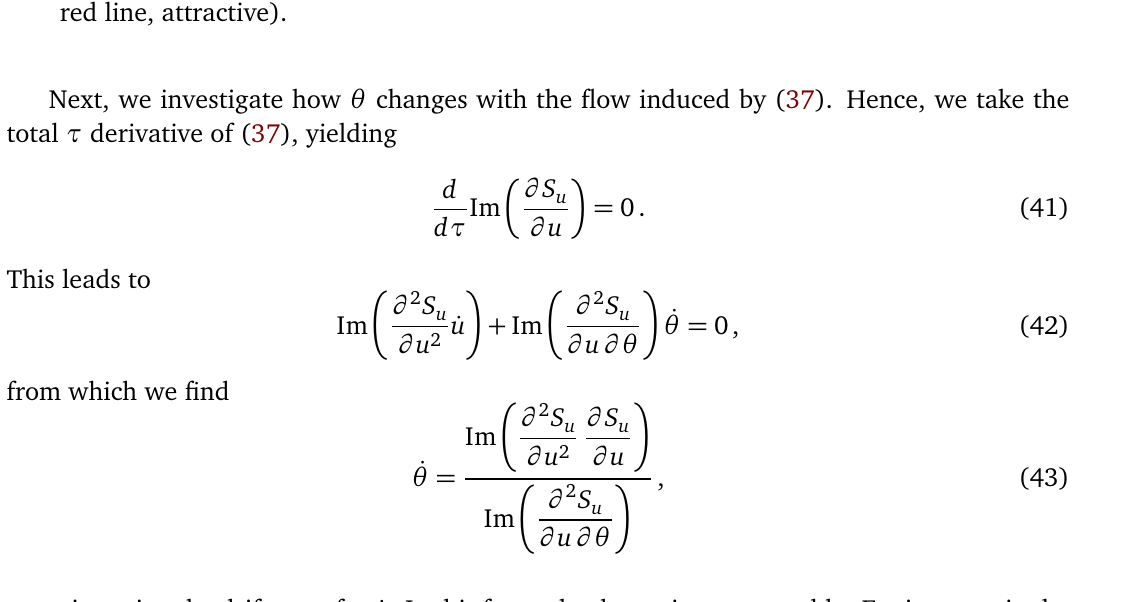
Figure 8: Visualization of the rotation of the complex plane for the Gaußian model with σ = 1 + i according to (44) after rotating the thimble onto the real axis. The arrows point in the direction of rotation. Here, the transformed thimble is the real axis (solid red line, repulsive), while the anti-thimble is the imaginary axis (dashed red line,